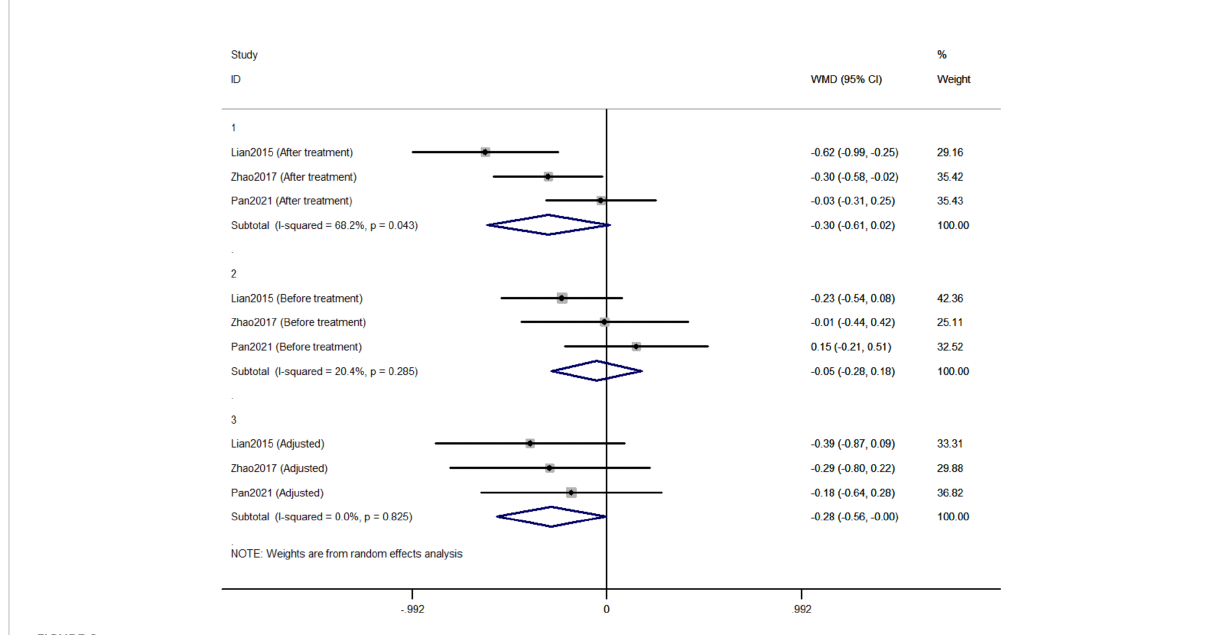
FIGURE 2 Forest plots of changes in HbA1c between Jinlida Groups and Control